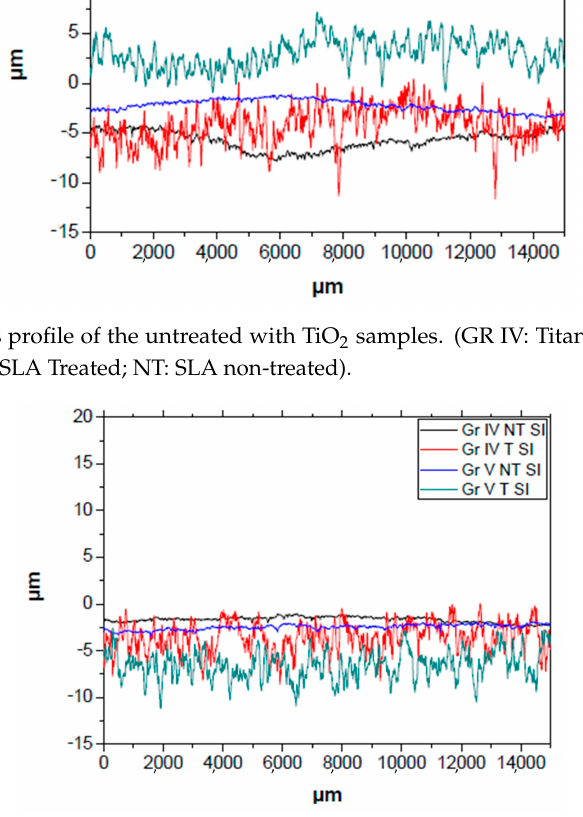
Table 6. Atomic percentages of the elements of the untreated with TiO 2 film and non-treated SLA grade IV and V samples and untreated with TiO 2 film and treated SLA grade IV and V samples. (GR IV: Titanium grade IV; GR V: Titanium grade V; T: SLA treated; NT: SLA